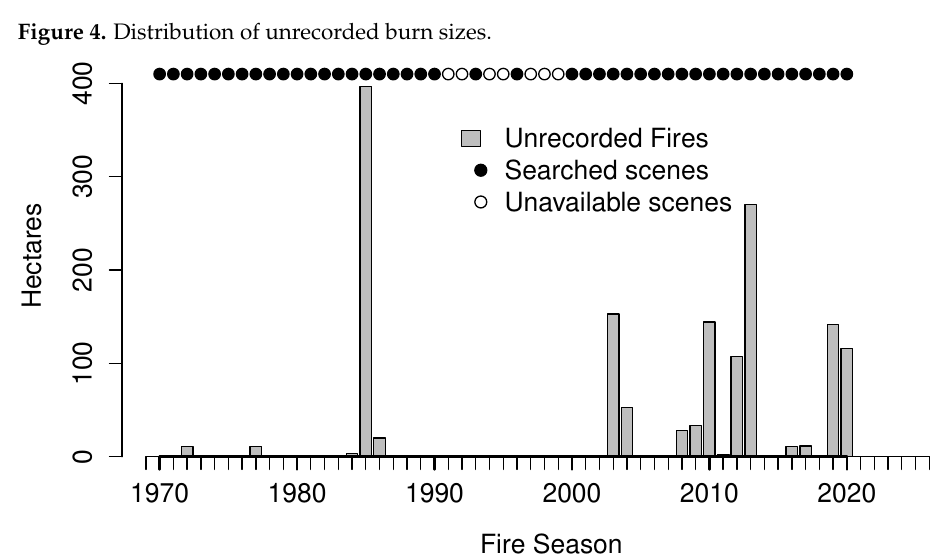
Figure 5. Area burned in unrecorded fires by season in the Brooks Range Foothills